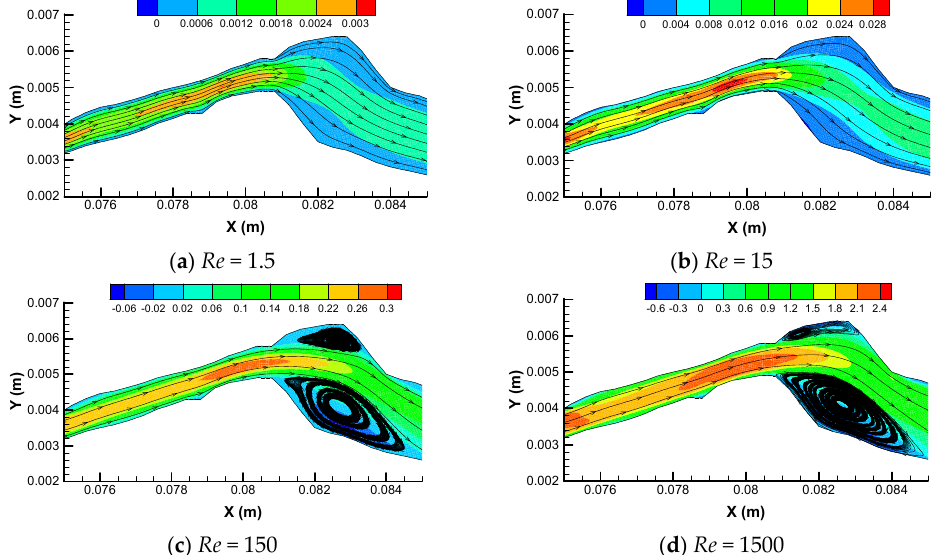
Figure 7. Eddy evolution resulting from different injection velocities, where JRC = 16.34 and d s = 2.0 mm. Re , Reynolds number.